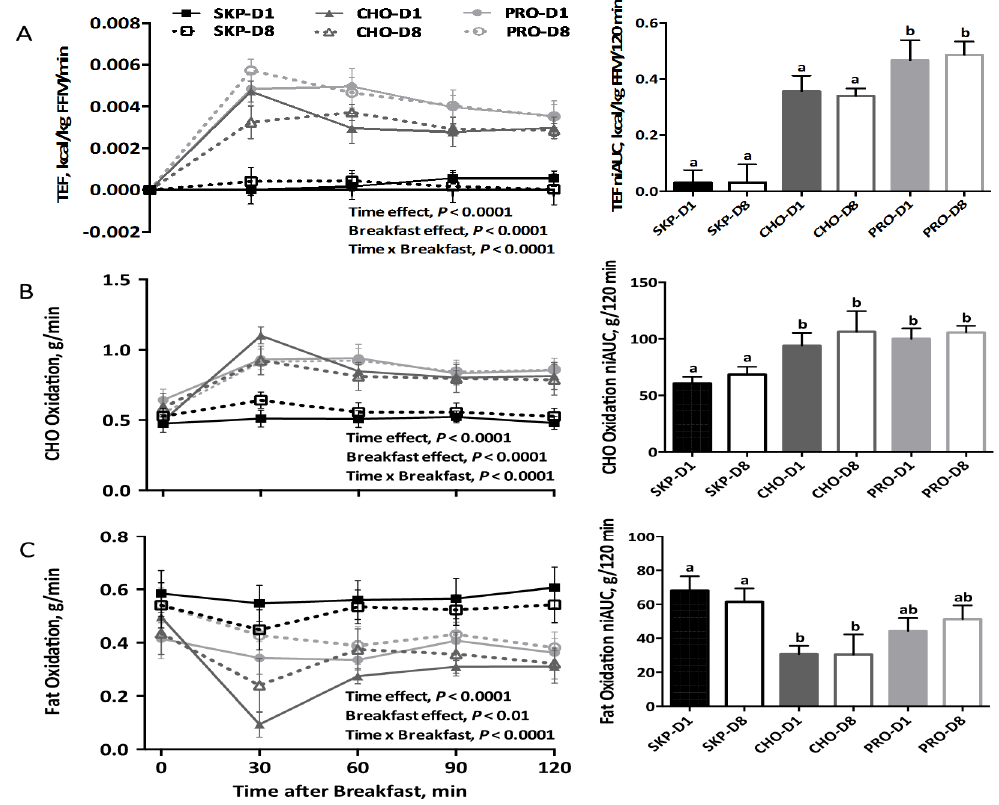
Figure 1. Energy expenditure and substrate oxidation following a PRO ‐ or CHO ‐ breakfast or continued breakfast skipping. Data are expressed as means ± SEMs; SKP n = 8, PRO n = 8, CHO n = 8. ( A ) Postprandial energy expenditure (TEF) controlled for fat ‐ free mass over time per breakfast group and niAUC for TEF for each breakfast group; ( B ) Carbohydrate oxidation over time per breakfast group and niAUC for carbohydrate oxidation for each breakfast group; ( C ) Fat oxidation over time per breakfast group and niAUC for fat oxidation for each breakfast group. Labeled bars without a common letter differ, p ≤ 0.05. SKP, breakfast skipping; CHO, carbohydrate ‐ based breakfast; PRO, protein ‐ based breakfast; FFM, fat ‐ free mass.